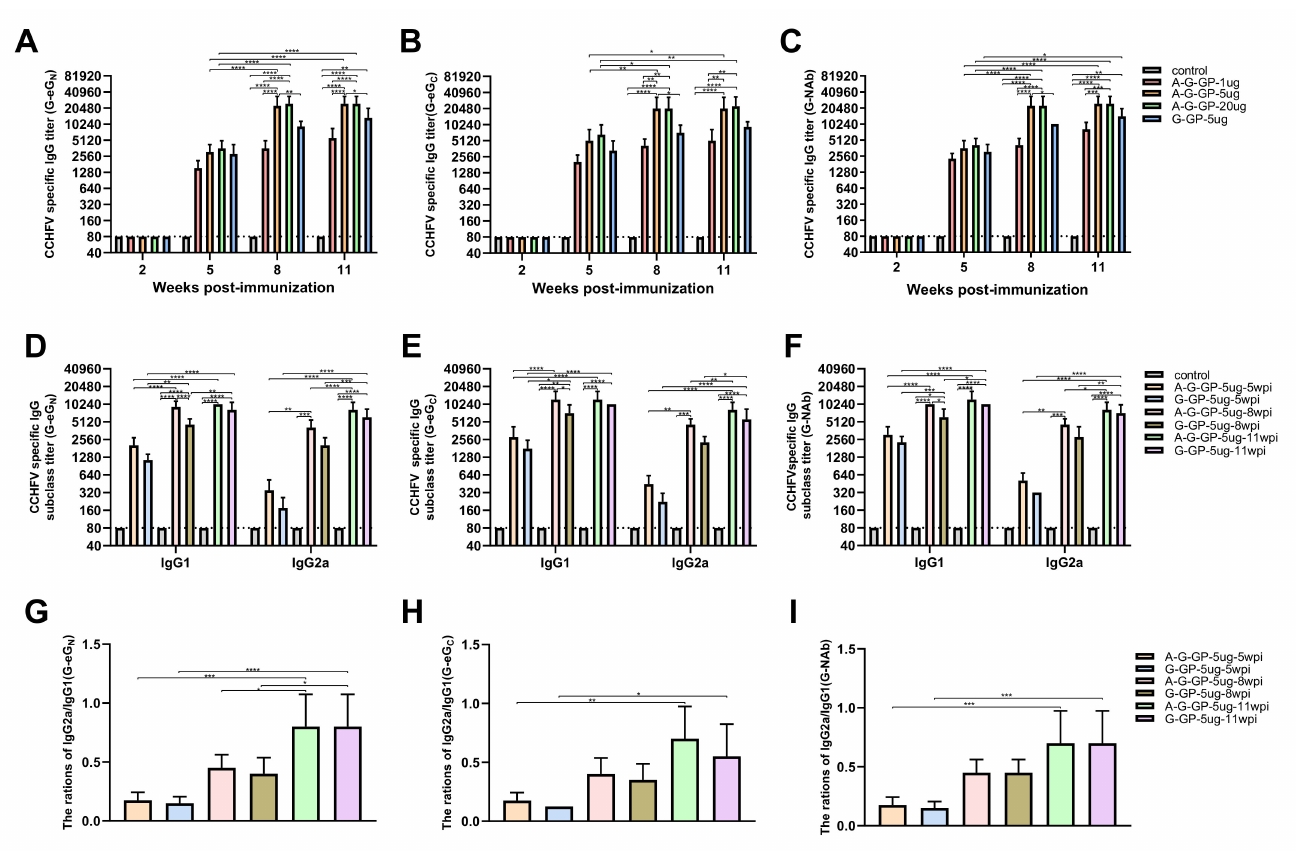
Figure 4. Serum antibody responses induced by CCHFV G-GP. Serum samples were col- lected by retro-orbital plexus puncture at weeks 2, 5, 8 and 11. CCHFV GP-specific total IgG ( n = 5 mice/group/time point), IgG1and IgG2a ( n = 5 mice/group/time point) antibody responses were measured by indirect ELISA with the purified eG N protein and eG C and are displayed as the end-point dilution titers. The horizontal dotted line in the figure indicates the limit of determination (LOD). ( A – C ) Analysis of serum antibody titers induced by different doses and time points on the immune system in mice by ELISA, data are shown as the mean ± SD and were analyzed by two-way ANOVA; ( D – F ) Analysis of serum antibody subclass titers induced by time points on the immune dose (5 µ g G-GP) by ELISA, data are shown as the mean ± SD and were analyzed by one-way ANOVA; ( G – I ) Analysis of serum antibody ratios of IgG2a/IgG1 induced by time points on the immune dose (5 µ g G-GP) by ELISA, data were shown as the mean ± SD and were analyzed by one-way ANOVA, * p < 0.05, ** p < 0.01, *** p < 0.001, **** p <